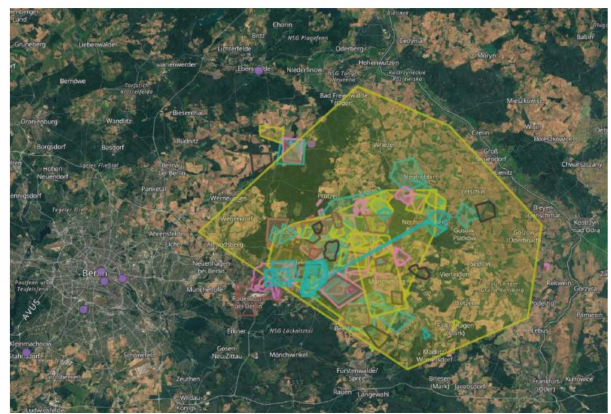
Figure A1. Screenshot of Maptionnaire survey